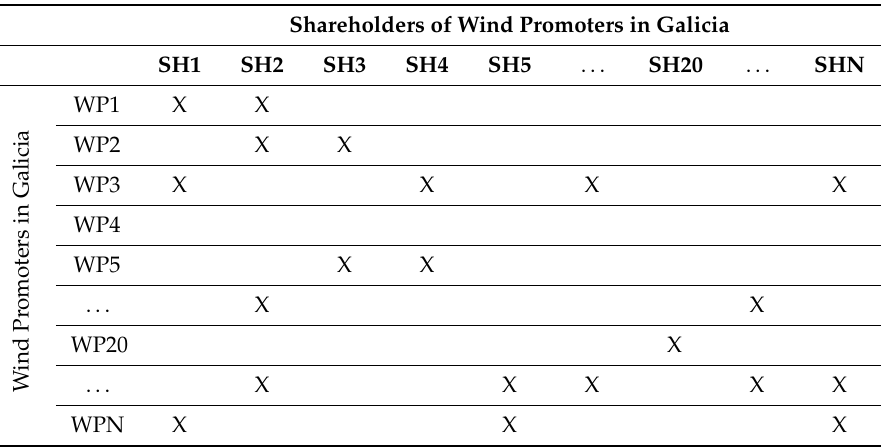
Table 2. Matrix of company relations elaborated from